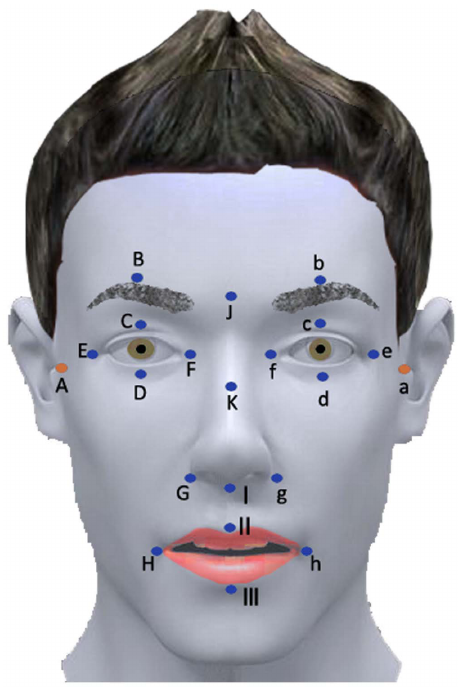
Figure 2. Observational points on face. A/a tragus parallel to the upper wall of external acoustic canal, B/b central position above the eyebrow, C/c center of the upper eyelid, D/d center of the lower eyelid, E/e angulus oculi temporalis, F/f angulus oculi medialis, G/g ala of the nose, H/h corner of the mouth, I root of the columella nasi, J center of eyebrows, K bony–cartilaginous junction along the nasal dorsum, II philtrum, III center of the lower lip.